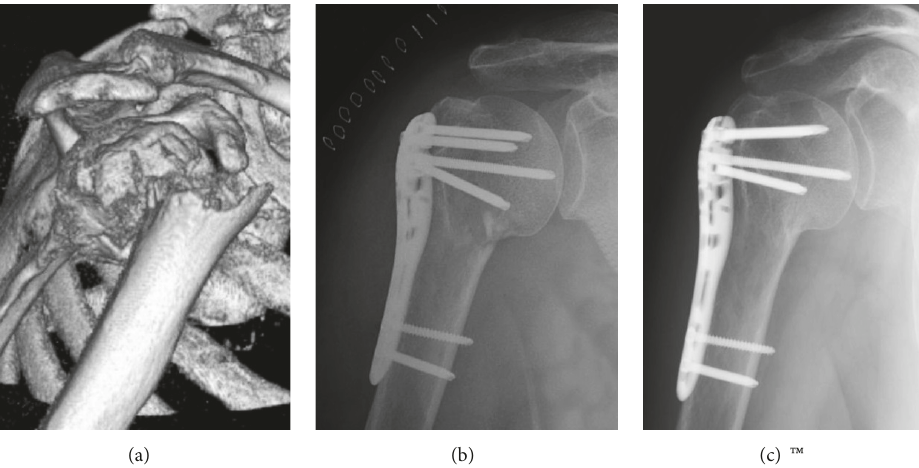
Figure 5: (a) Two-part varus nonimpacted fracture of the surgical neck (AO/OTA type A3) in a 71-year-old woman. (b) Anatomical reduction was not achieved at time of surgery: postoperative radiogram showed mild varus angulation of the humeral head. (c) One year after surgery fracture was healed without any aggravation of the varus.